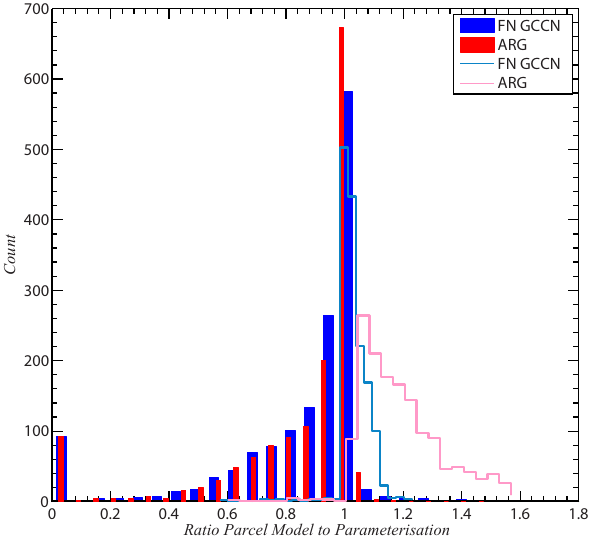
Figure 6. Histogram of the ratio of number of activated drops cal- culated by the parcel model to the number of activated drops cal- culated by FN GCCN and ARG parameterisations. Solid bars for monomodal runs and lines for bimodal